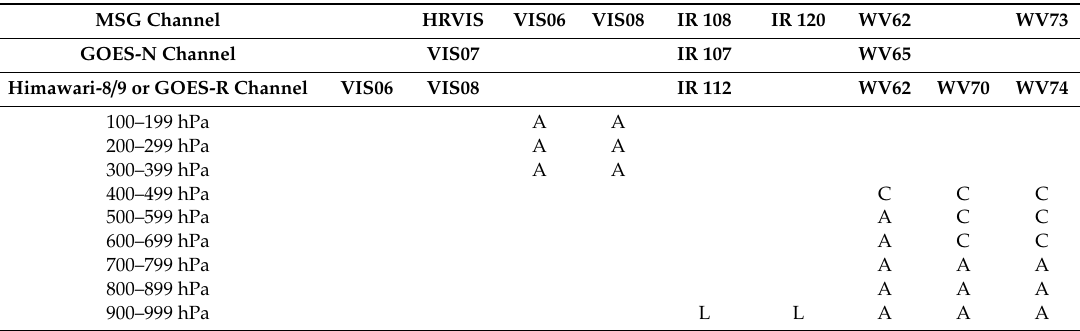
Table 3. AMV filtering related to the AMV pressure (in rows) and the satellite channels used for the AMV calculation (in columns). ‘C’ means clear air AMVs removed; ‘A’ means all AMVs removed; ‘L’ means all AMVs removed if so configured (not in the default